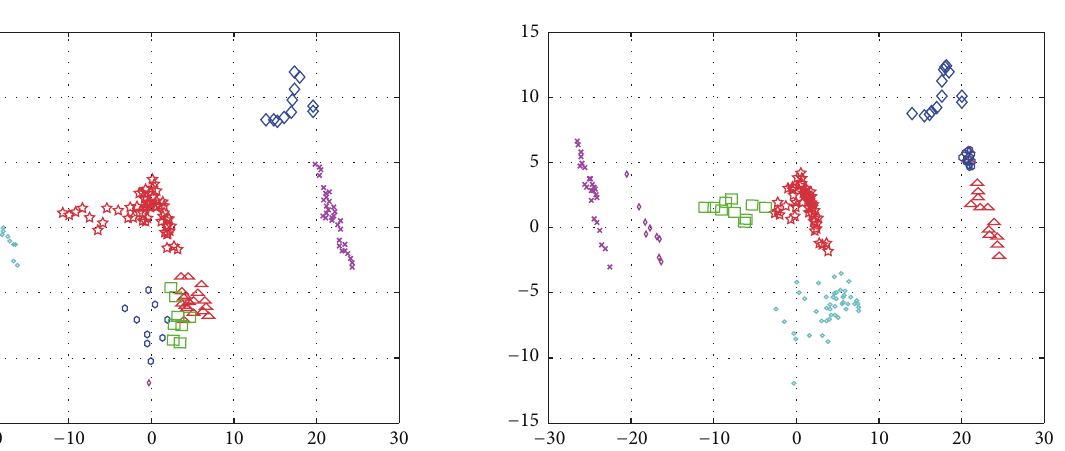
Figure 10: Clustering results obtained by standard K -means.